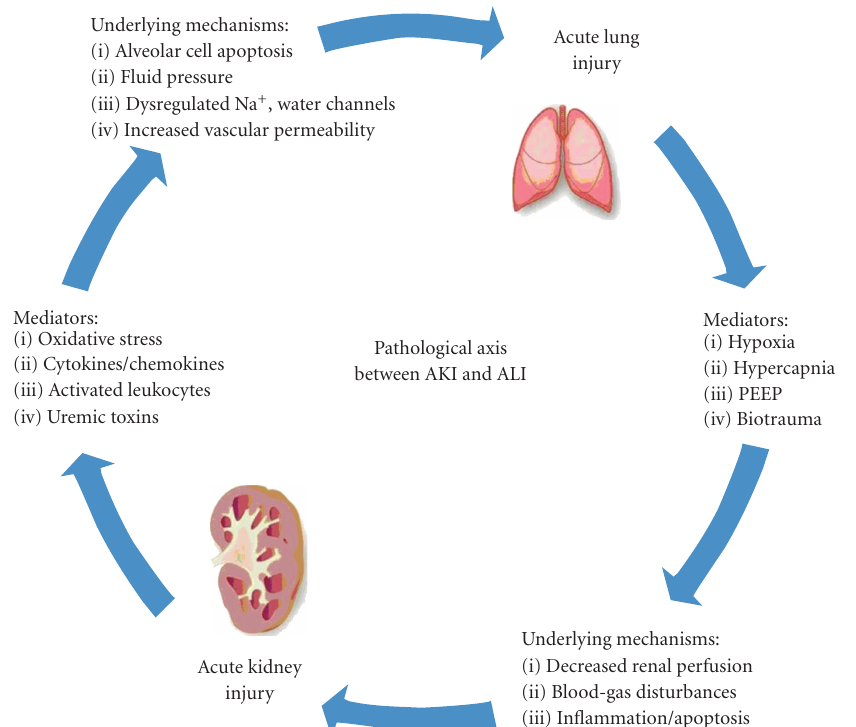
Figure 2: Pathological Axis between AKI and ALI. AKI induces pathophysiologic e ff ects on the lung via cellular and soluble mediators. ALI, in turn, exacerbates kidney dysfunction through metabolic and biochemical